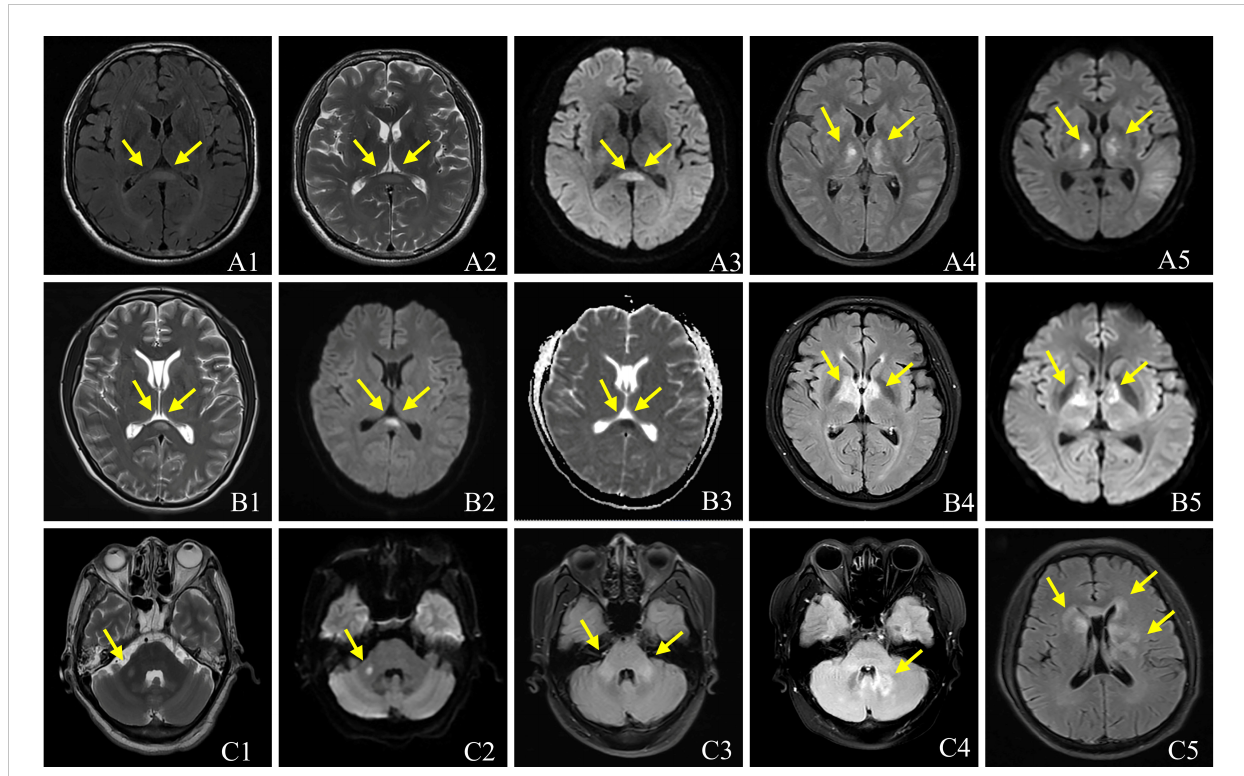
FIGURE 2 Brain MRI characteristics of patients with Anti-GFAP antibodies. The imaging looks like a reversible splenial lesion (A1-A3, B1-B3) . T2 FLAIR (A4, B4) and Diffusion Weighted Imaging (A5, B5) show lesions in bilateral thalamus, T2-weighted (C1) image and FLAIR (C2, C3) show lesions in brachium pontis; T2 FLAIR shows lesions in cerebellum (C4) , basal ganglia (C5) and paraventricular (C5)